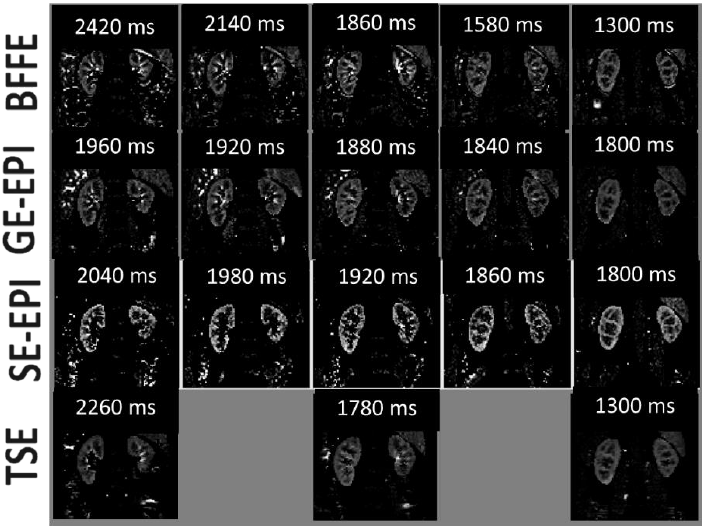
Figure 3. Example perfusion-weighted images (PWI) for each scheme (bFFE, GE-EPI, SE-EPI, and TSE) from a single subject. The post-label delay of each slice is indicated on each image.